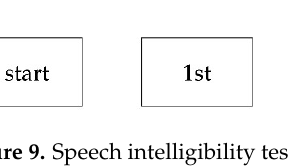
Figure 9. Speech intelligibility test progress.